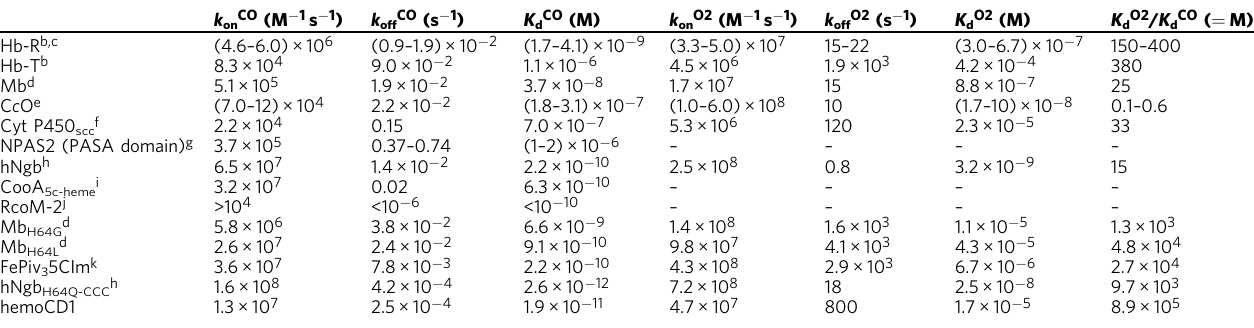
Table 2 Kinetic and thermodynamic parameters for O 2 and CO bindings of hemoCD1 and related hemoproteins and model compounds a